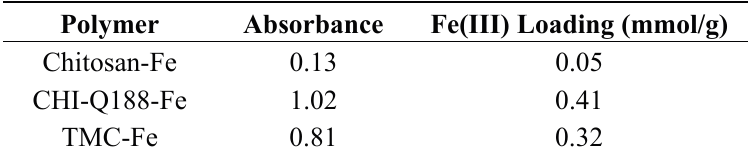
Table 1. Absorbance values with corresponding Fe(III)-loading values for the polymers